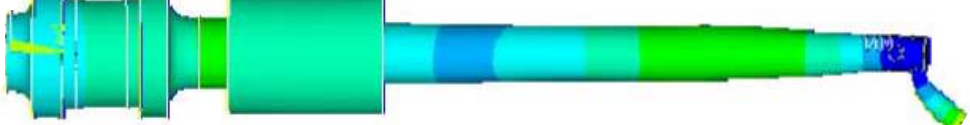
(a) Longitudinal mode shape of transducer of mode at 95 kHz.